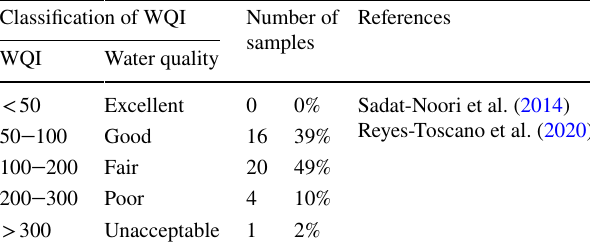
Table 4 WQI for the groundwater samples in the study area Classification of